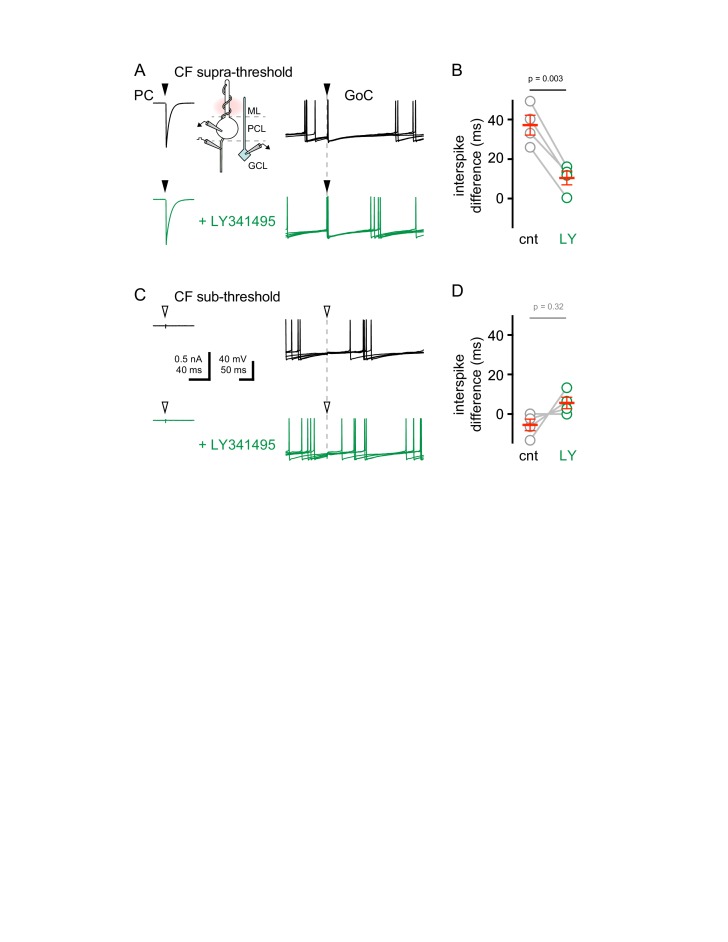
CF-mediated GoC spike suppression is mGluR2 dependent.(A, Top) Simultaneous recordings of PC EPSC (left) and GoC APs (right, five traces overlaid) with supra-threshold CF stimulation (filled arrows). (A, bottom) Same recording configuration as above with LY341495 (green) application. Schematic of paired recording configuration is shown between PC and GoC traces. Scale as in (C). (B) Summary plot (circles are individual cells and mean ±sem are in red) of first interspike difference (after CF stimulation) before (grey, 37.2 ± 5 ms) and following LY3414395 application (green, 10.4 ± 3.5 ms, n = 4; ANOVA comparison with post test between cnt v LY). The baseline interspike interval was subtracted from each cell (average: 167.7 ± 13.6 ms, n = 4). The interspike interval before subtraction was 204.8 ± 18.3 ms (control) and 178.1 ± 16.4 ms in (LY3414395). In a separate set of experiments, the baseline interspike interval (before stimulation) was 172.5 ± 10.0 ms (n = 38). (C, top and bottom) Same experimental paradigm as in (A) with sub-threshold CF stimulation (empty arrows) in control (black) or in the presence of LY341495 (green). (D) Summary plot (circles are individual cells and mean ±SEM are in red) of first spike interspike difference before (grey, −5.5 ± 2.9 ms) and following LY3414395 application (green, 5.6 ± 2.9 ms, n = 4). The baseline interspike interval was subtracted from each cell. The interspike interval before subtraction was 162.2 ± 10.8 ms (control) and 173.3 ± 16.4 ms (in LY3414395).